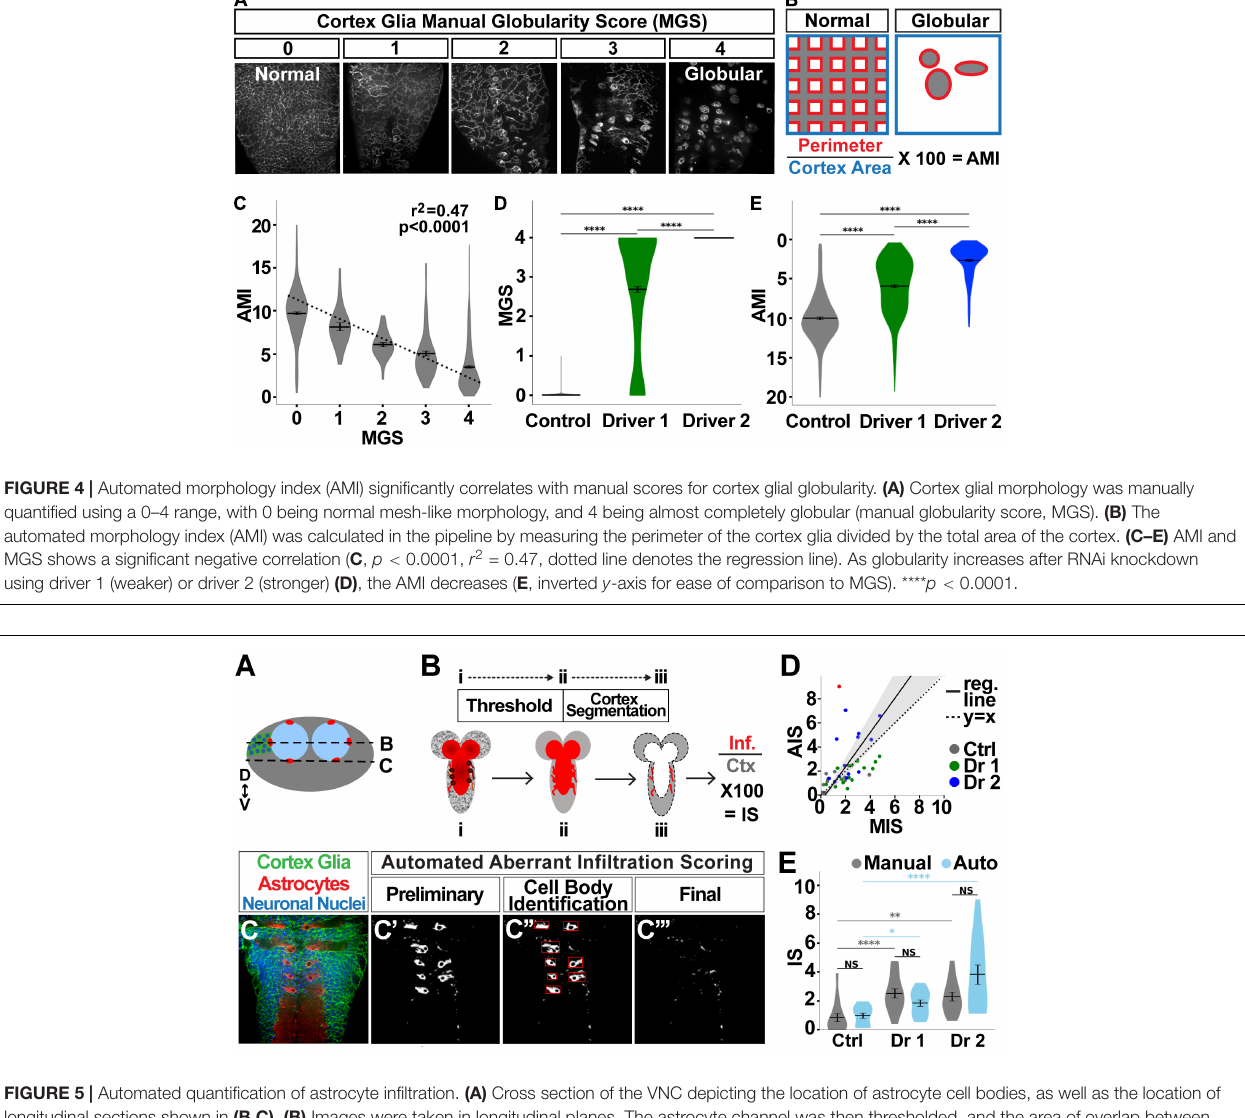
same images, and finding a very high level of agreement between [249 images: ICC(3,k) = 0.983, p < 0.0001, Supplementary Figure 4 ]. When MGS scores were sorted by experimental group, the same patterns were revealed by MGS ( Figure 4D ) and AMI ( Figure 4E , y -axis flipped for ease of comparison to Figure 4D ). The no-RNAi control condition exhibited the lowest cortex glia globularity, indicative of normal